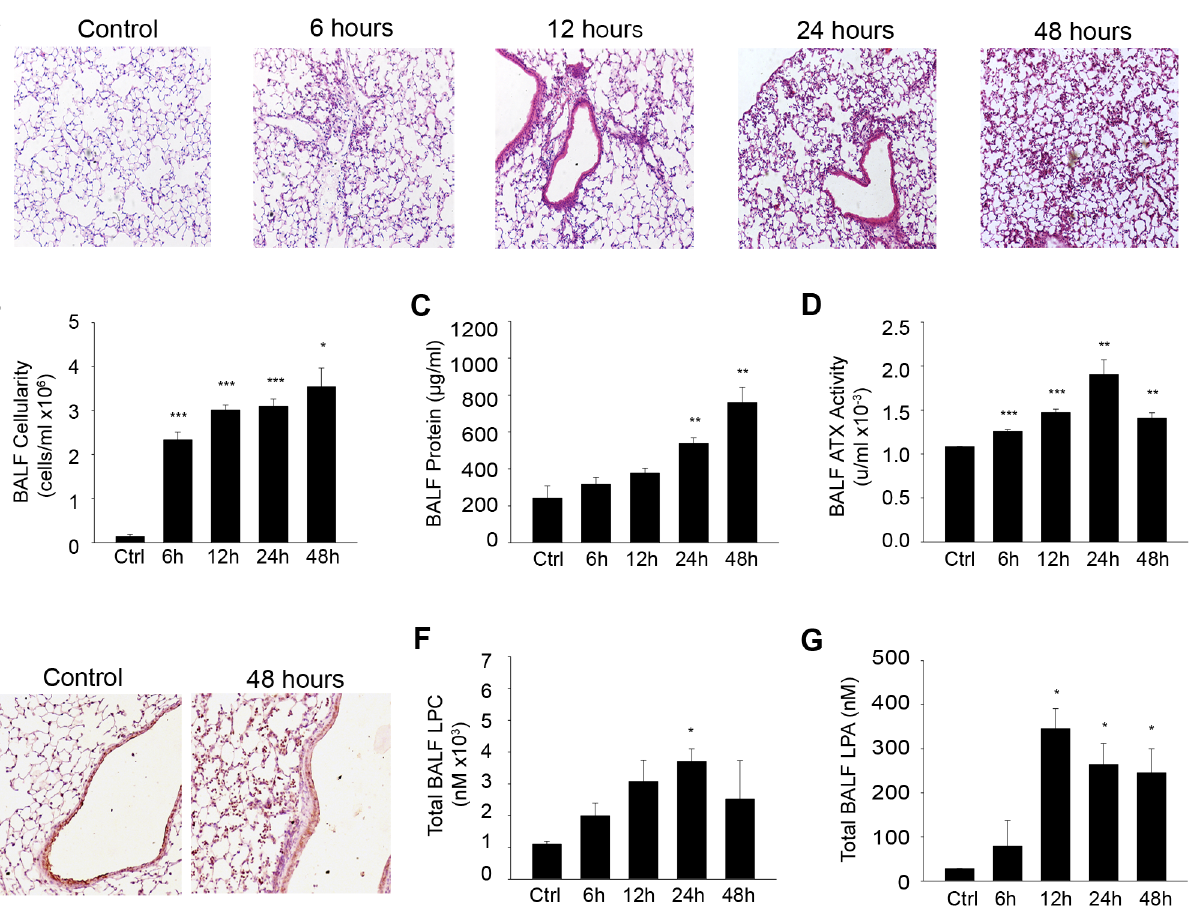
Fig 1. Increased BALF ATX/LPA levels upon LPS-induced ALI. Mice were administered aerosolized LPS and were sacrificed 6, 12, 24 and 48 hours later (n = 3 – 5; a representative experiment out of two is shown). A. Hematoxylin & Eosin staining of lung tissue sections following LPS exposure for the indicated times resulted in alveolar wall thickening and leukocyte infiltration into the lung interstitium and alveolar space. B. Increased BALF cellularity upon LPS/ALI. C. Pulmonary microvascular leakage and edema induced by LPS was reflected in BALF protein content. D. Increased ATX activity in LPS/ALI BALFs, as measured with the TOOS assay. E. IHC for ATX in lung tissue showing constitutive expression from the bronchial epithelium, as well as a weak diffuse staining pattern in the lung parenchyma. F-G. BALF total LPC/LPA levels respectively upon LPS/ALI, as measured with HPLC-MS/MS.